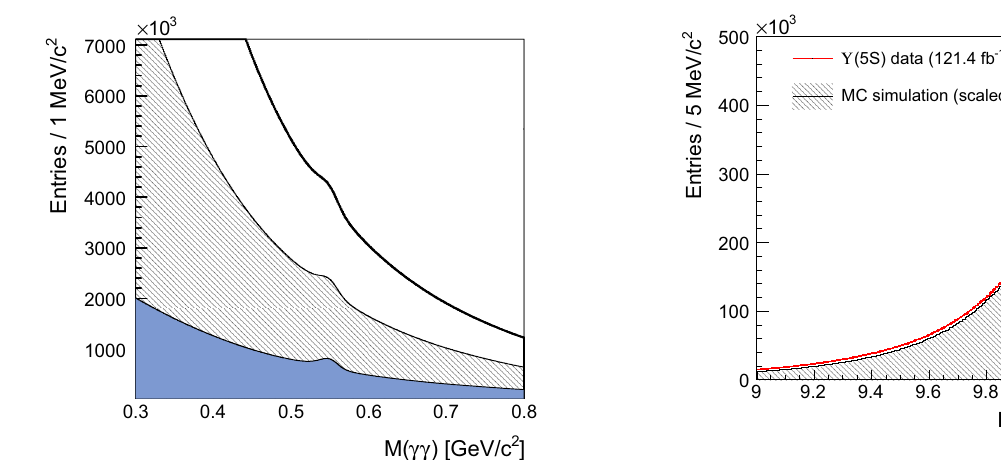
to improve the resolution on the missing mass. To reduce